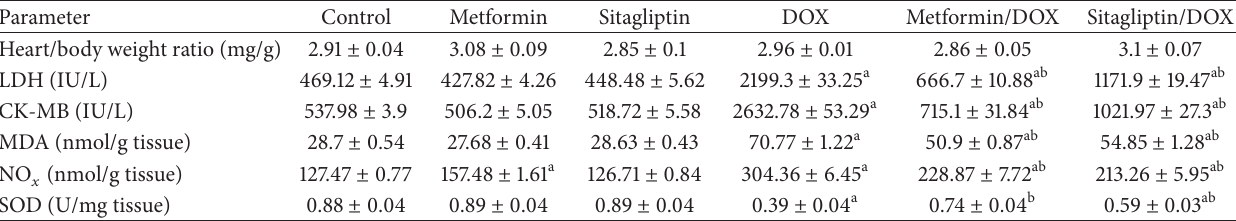
Table 1: Effect of metformin or sitagliptin on DOX-induced cardiotoxicity in rats.